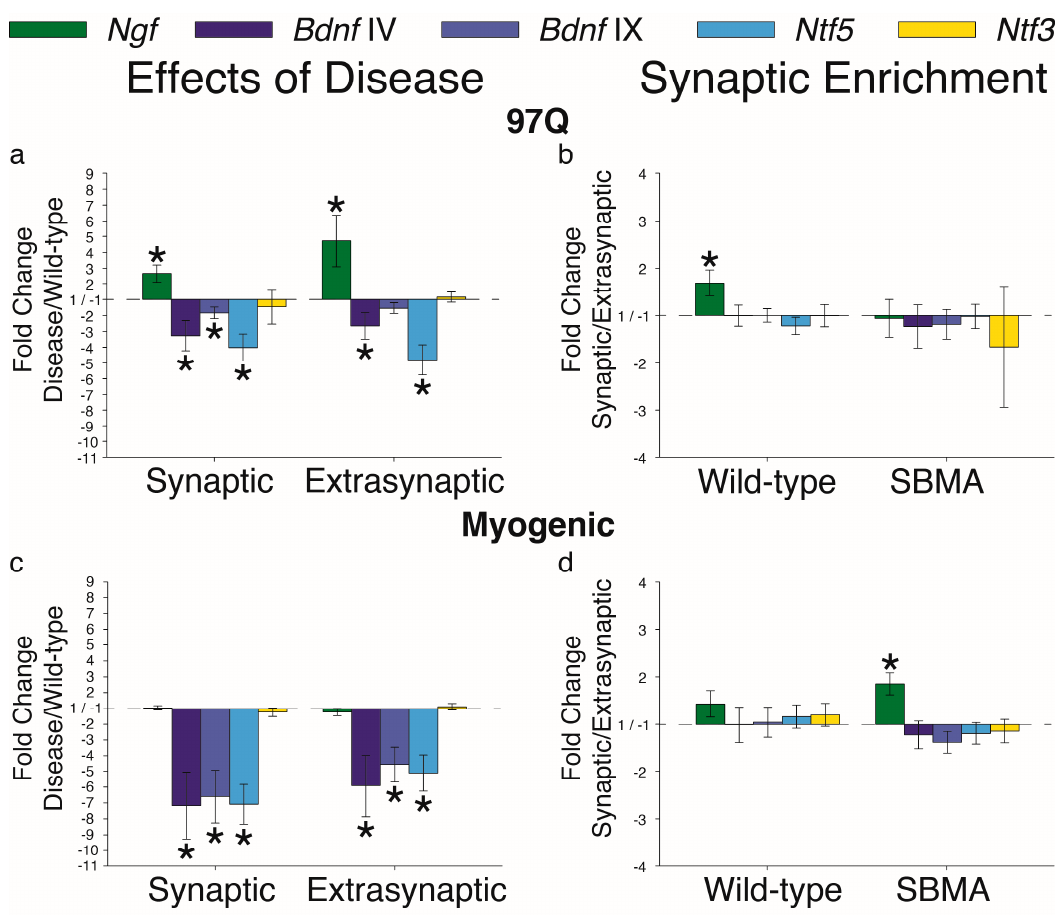
Figure 2. Neurotrophin mRNA expression in synaptic and extrasynaptic regions of skeletal muscle is largely comparably affected by disease. ( a , c ) Ngf was upregulated in the 97Q model but not in the myogenic model, possibly reflecting specific effects of a polyglutamine expanded AR expressed only in the 97Q model. On the other hand, Bdnf IV and IX variants were downregulated in both the 97Q and myogenic models, as we have previously reported. Ntf5 was also downregulated in both models, aligning with previous findings in the knock-in model. Notably, Ntf3 was not affected by disease in either model, indicating that disease affects most, but not all, of the neurotrophins expressed in skeletal muscle. ( b , d ) There were no consistent differences in neurotrophin mRNA expression between synaptic and extrasynaptic regions for either WT or diseased muscle from the two models examined. Fold changes ± SEM are relative to wild-type ( a , c , e ) or extrasynaptic ( b , d , f ) samples; Statistical analysis was based on pair-wise fixed reallocation randomization test: * p < 0.05.